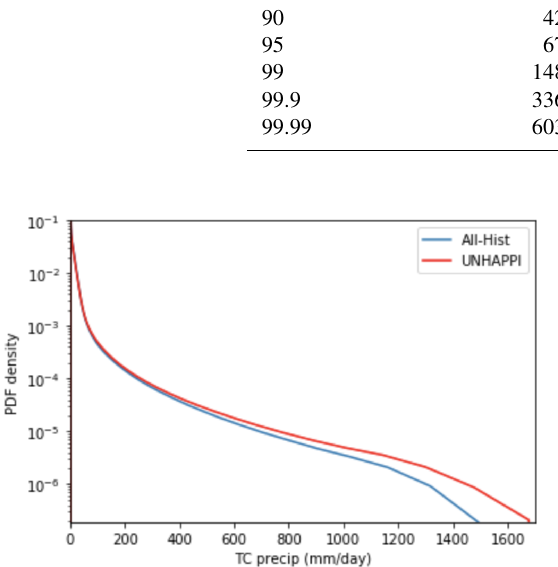
Figure 9. Conditional PDF for tropical cyclone precipitation com- puted using fastKDE (O’Brien et al., 2016).